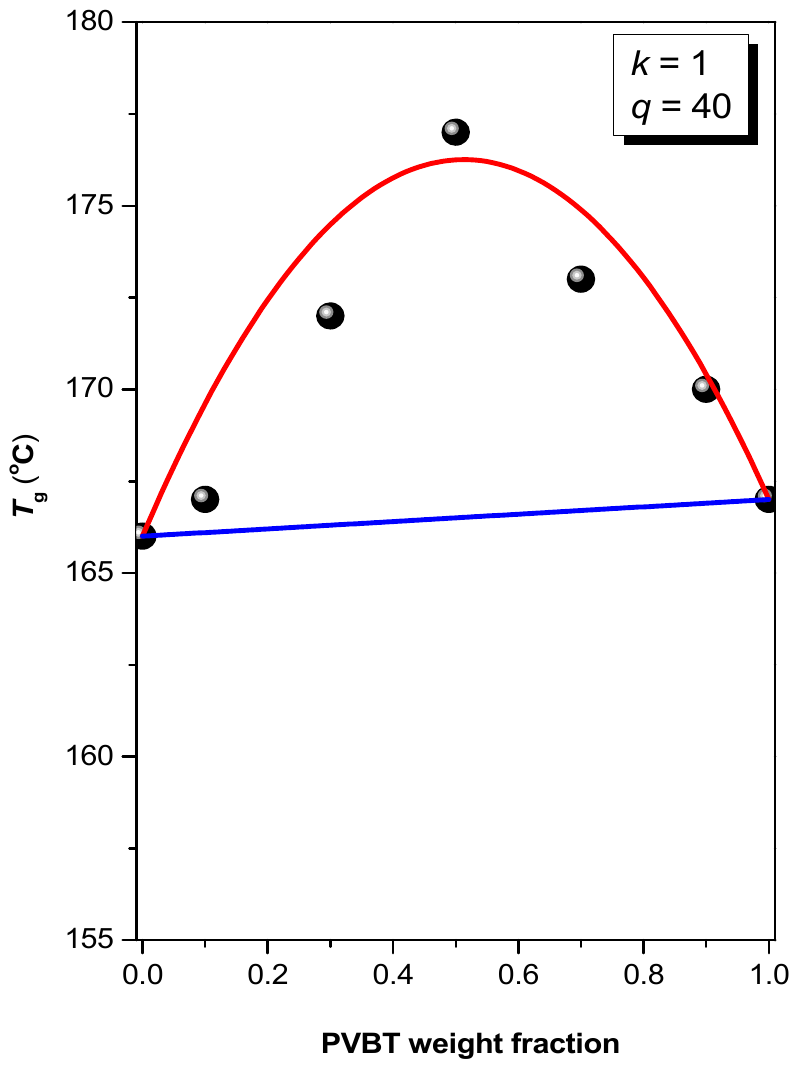
Figure 5. Glass transition temperature composition curve for PS- b -PVBA/PVBT blends, based on the Kwei equation.